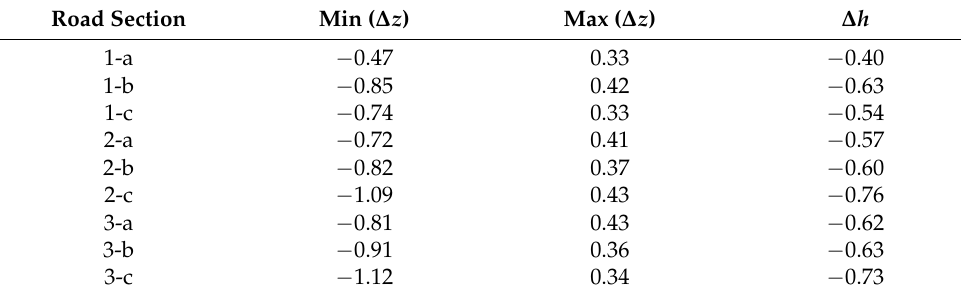
Table 3. Threshold values for each road segment (cm).